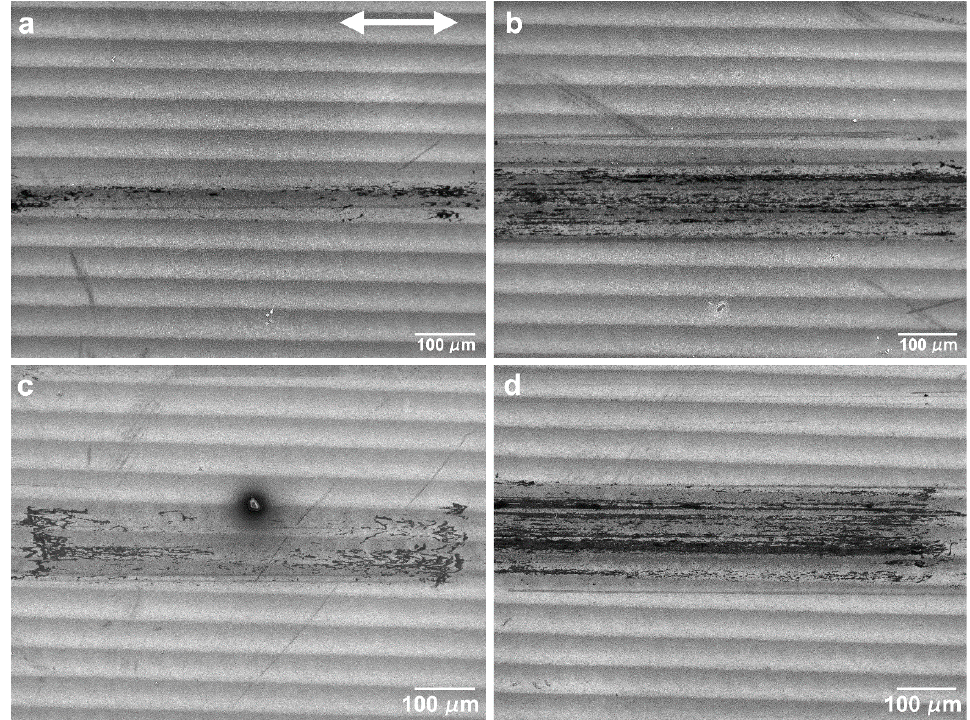
Figure 15. SEM micrographs of the wear tracks of the textured specimen in the perpendicular direction at 10 mN ( a ) after 50 cycles and ( b ) 1000 cycles and at 25 mN ( c ) after 50 cycles and ( d ) 1000 cycles. The double arrow indicates the sliding direction.